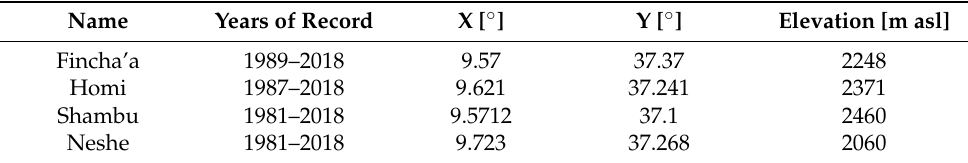
Table 1. Meteorological stations of the Fincha’a watershed.